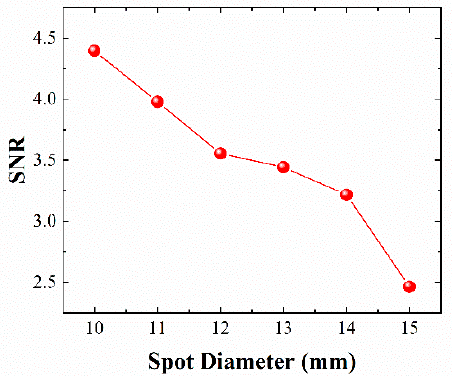
Figure 5. SNRs with different spot sizes under the same measurement conditions.